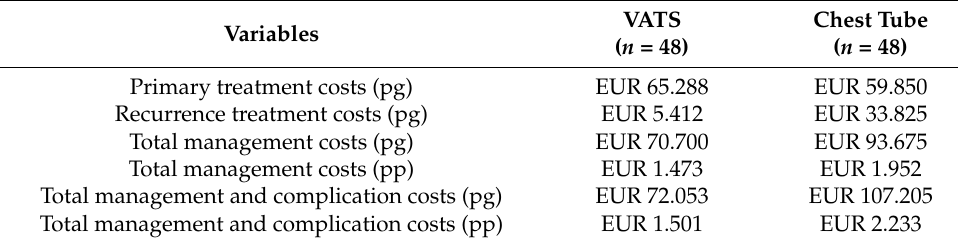
Table 6. Total management